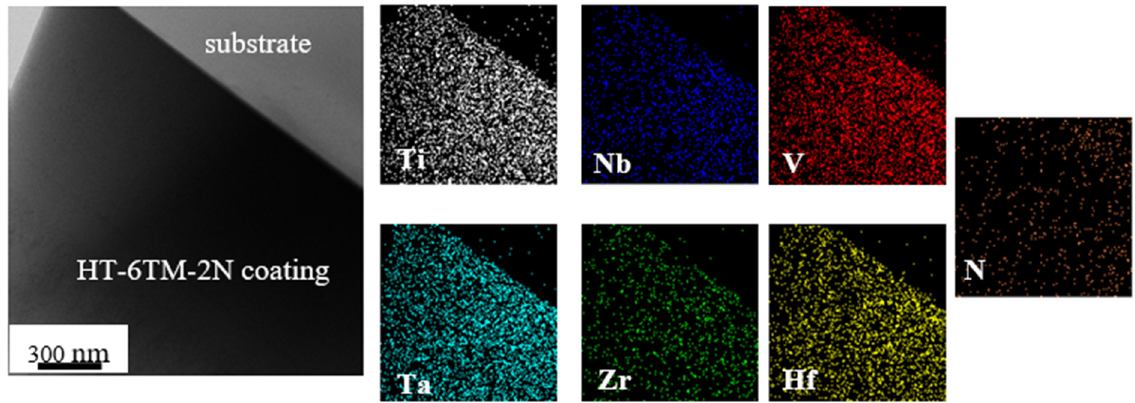
Figure 8. The distribution of nitrogen and TM elements in TiNbVTaZrHf-2N coating by EDS. EDS mapping applied to the 6TM-6N coating produced distributions practically identical to those in Figure 8 and confirmed the presence of a homogeneous solid solution.